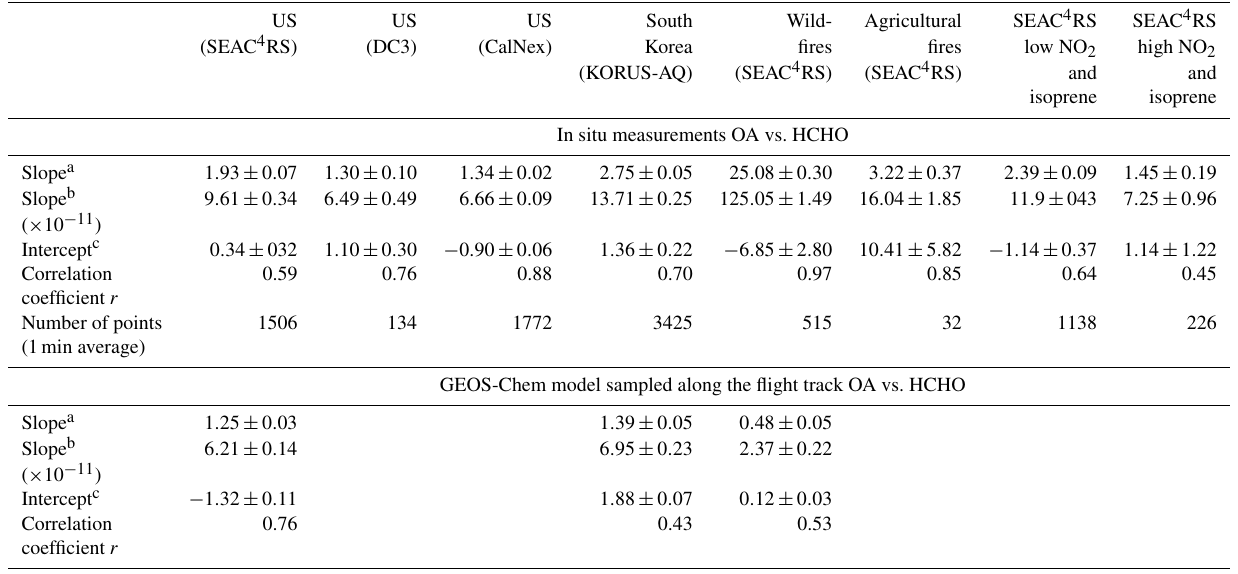
Table 1. Linear regression parameters for OA vs. HCHO at low altitudes (<1km). US US US South Wild- Agricultural SEAC 4 RS SEAC 4 RS (SEAC 4 RS) (DC3) (CalNex) Korea fires fires low NO 2 high NO 2 (KORUS-AQ) (SEAC 4 RS) (SEAC 4 RS) and and isoprene isoprene In situ measurements OA vs.